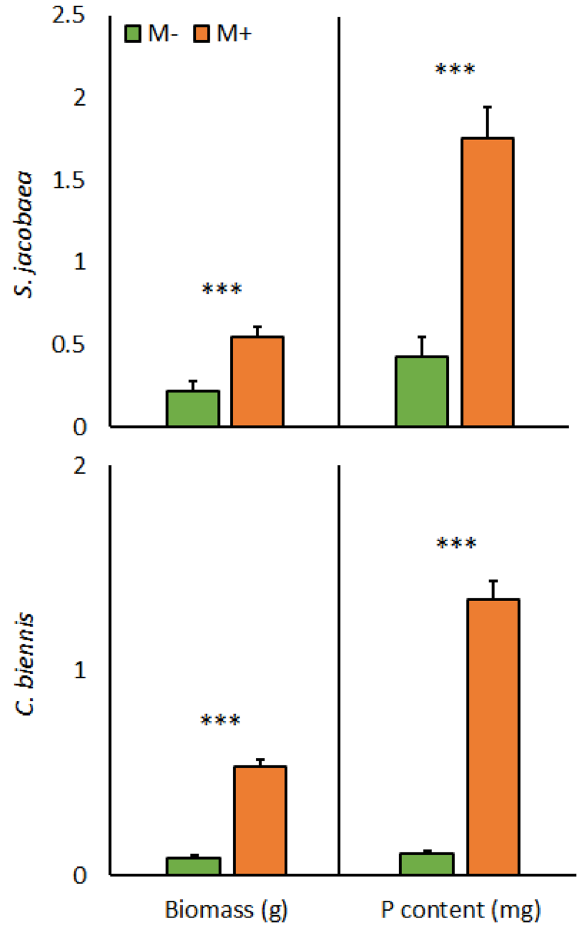
Figure 2. Shoot biomass and phosphorus content of perennial plant species Senecio jacobaea and Crepis biennis either paired with C. canadensis and E. annuus , respectively, or not, as affected by mycorrhizal inoculation (M+: mycorrhizal inoculum added; M−: nonmycorrhizal control). Bars represent means accompanied by standard errors (n = 20).